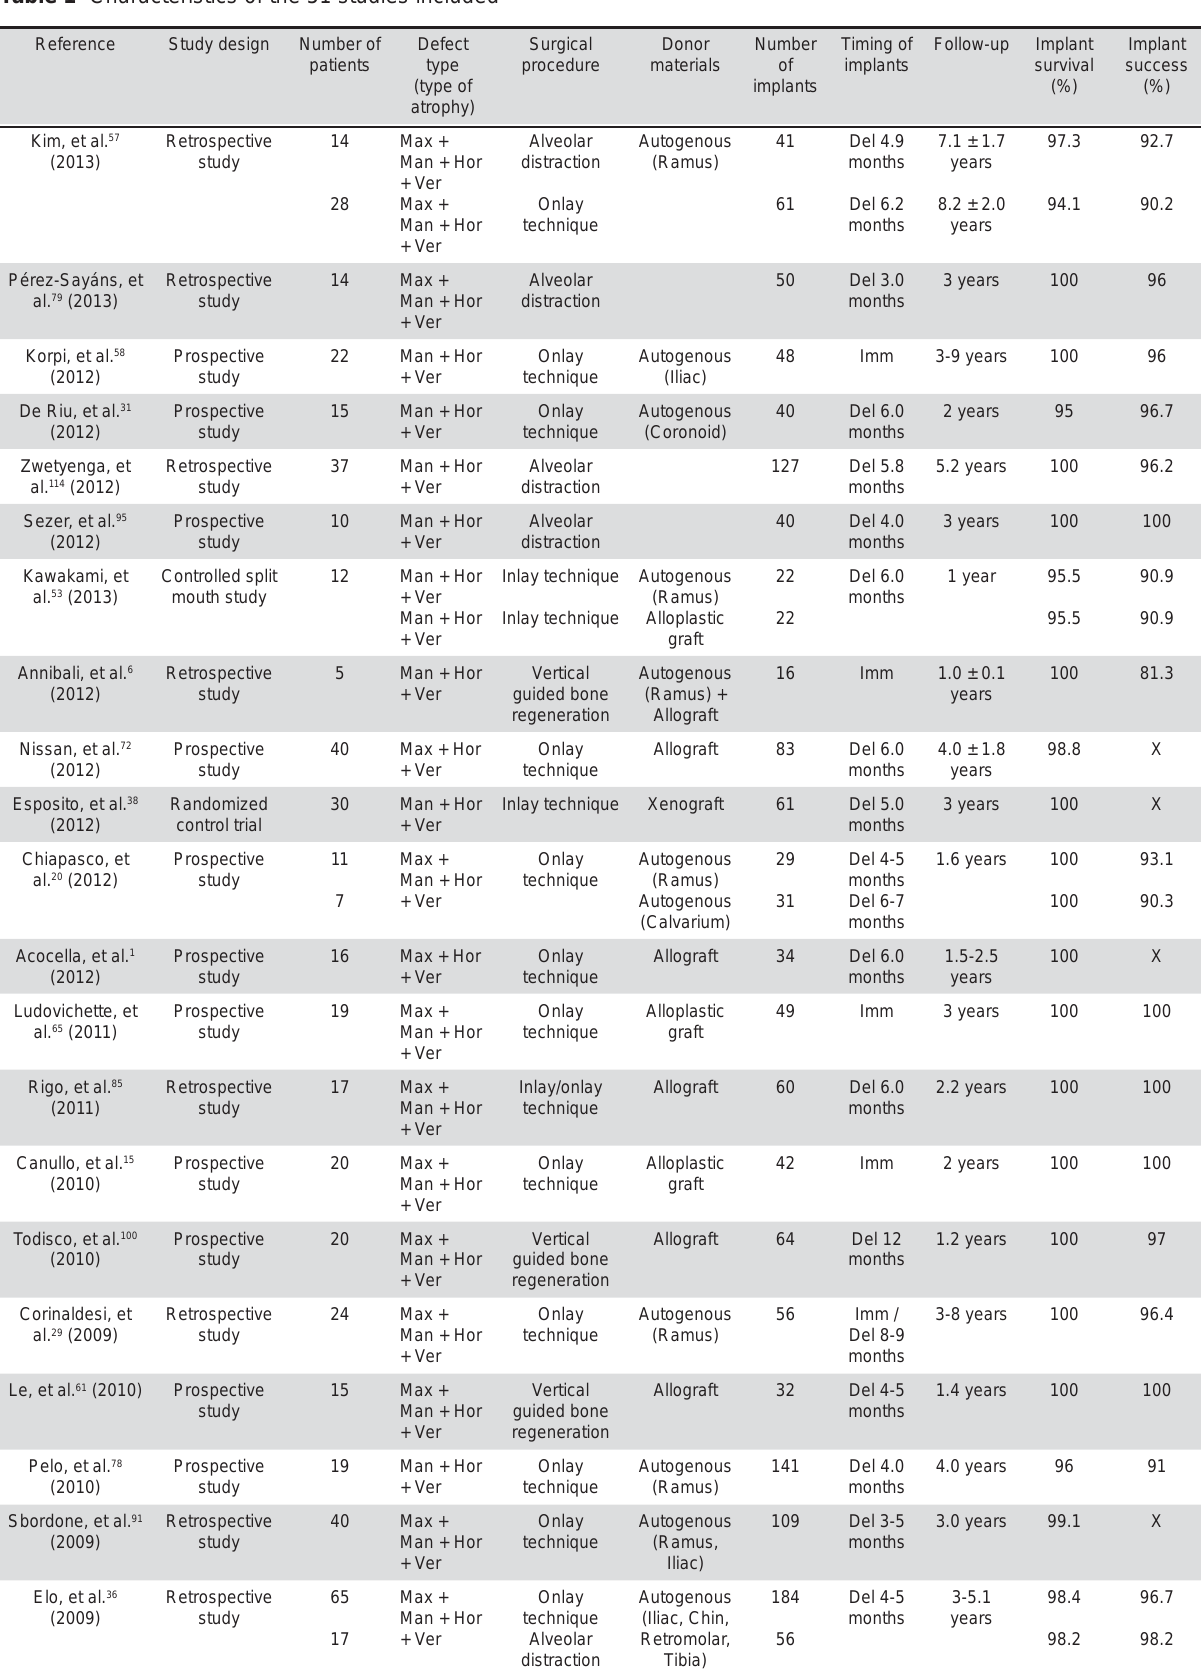
Table 1- Characteristics of the 51 studies